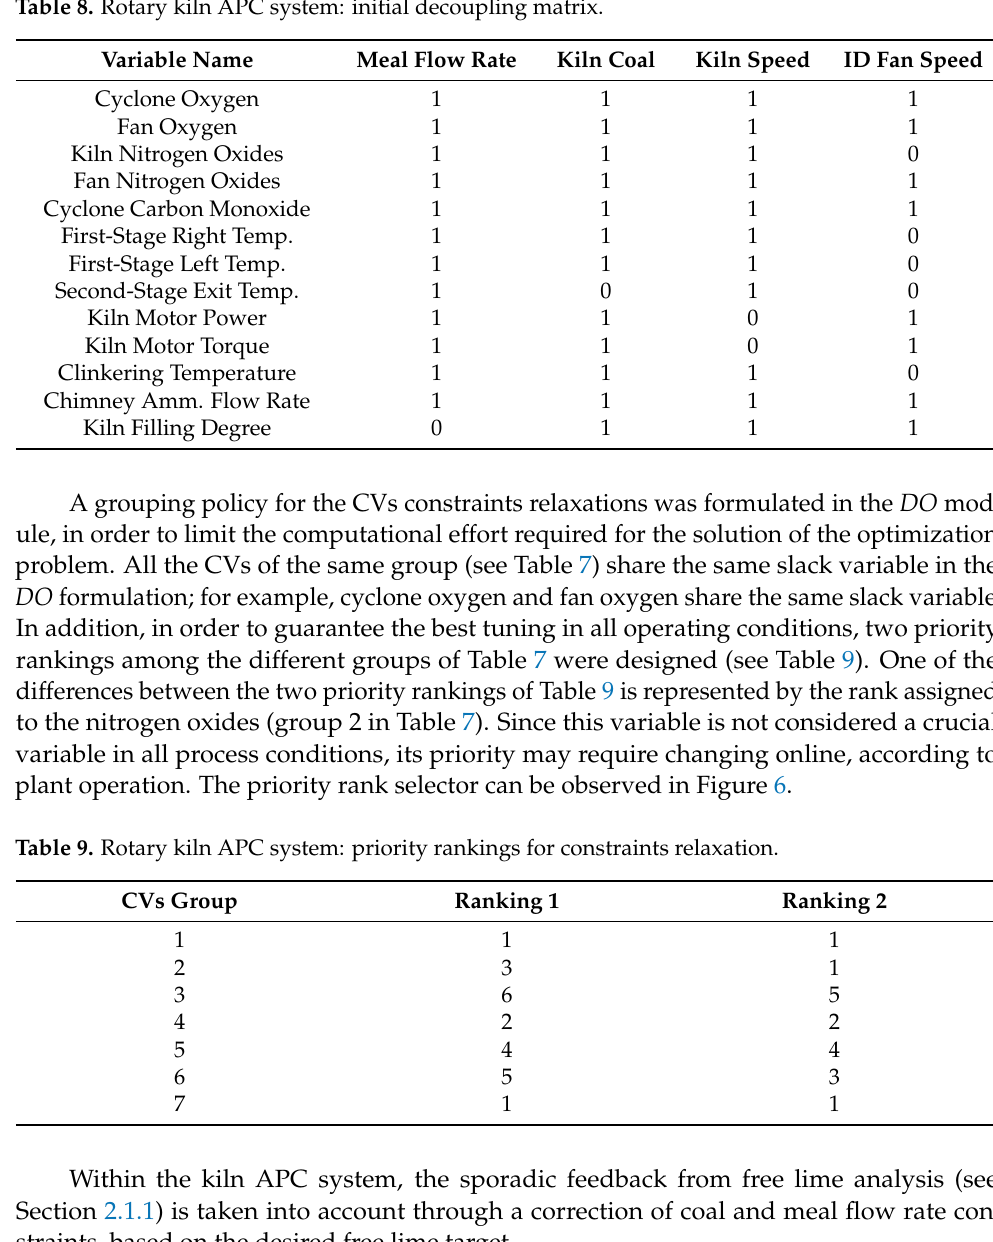
Table 8. Rotary kiln APC system: initial decoupling matrix.